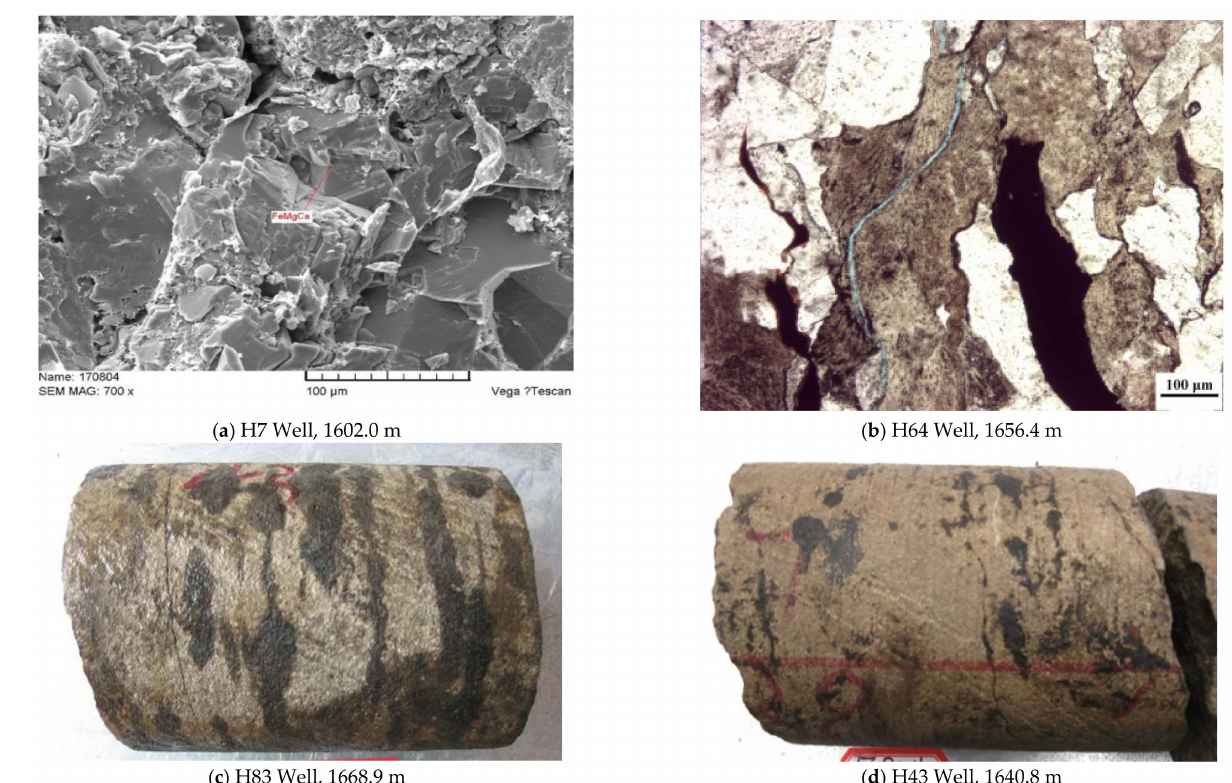
Figure 5. Natural fractures are well-developed in tight sandstone cores, which were obtained from the Heshui Region of Ordos Basin, China. ( a ) was obtained from the scanning electron microscopy (SEM) test. ( b ) was obtained from the thin section petrography (TSP) test. ( c , d ) are images of whole core retrieved from H83 Well and H43 Well,